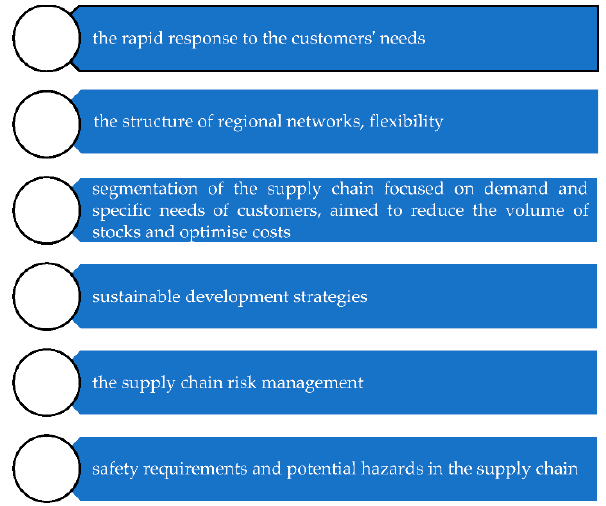
Figure 1. Critical success factors in logistics.